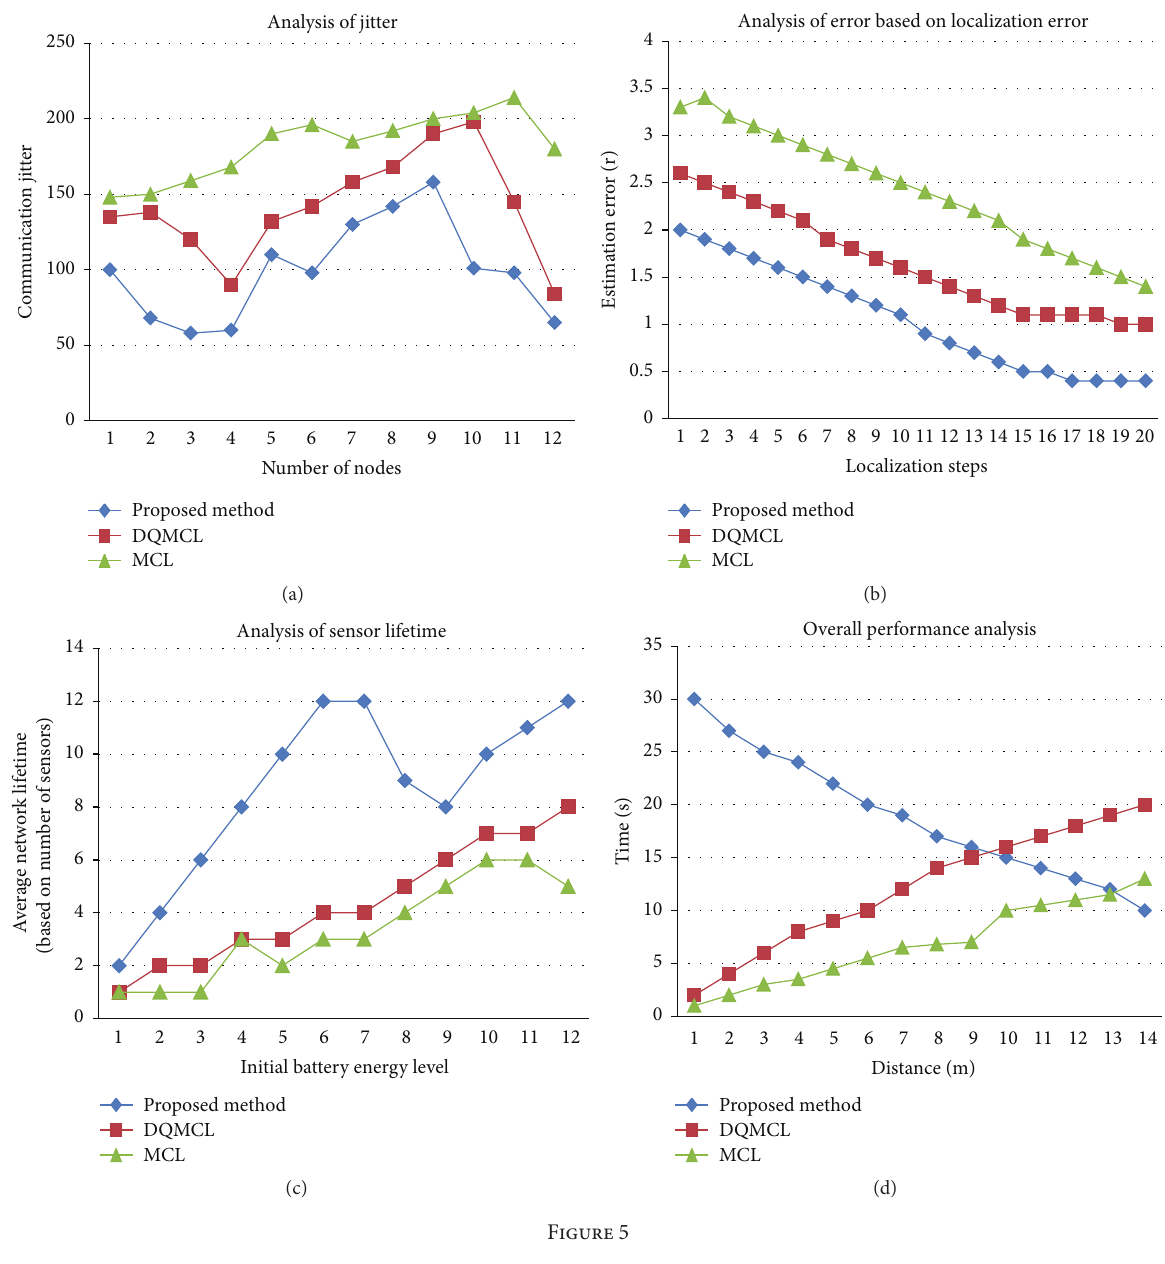
Table 2: RSSI analysis with predefined